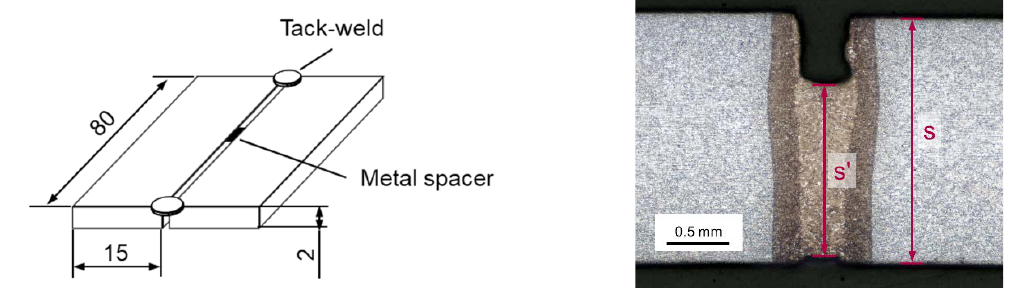
Figure 1. Sample dimensions for the welding trials ( left ) and evaluation of the cross-section ( right ).